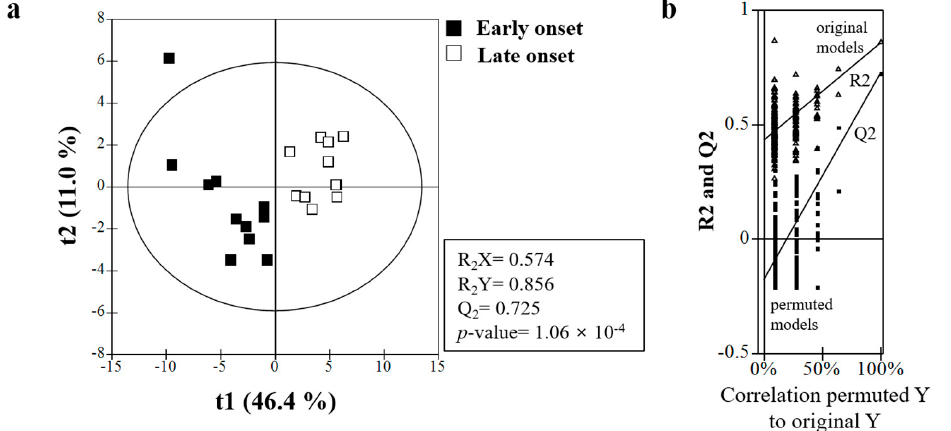
Figure 2. ( a ) Partial least-squares discriminant analysis (PLS-DA) scores obtained from UPLC-Q- TOF MS data. Outliers from the elliptical region of the 95% confidence interval were excluded by Hotelling’s T2 test. The scores plots showed significant separation between the samples based on the parameters of model quality: R2X, R2Y, and Q2Y. ( b ) The PLS-DA model was validated by a permutation test ( n = 200): p -values and intercepts of R2 (Ri) and Q2 (Qi). UPLC − Q-TOF-MS,